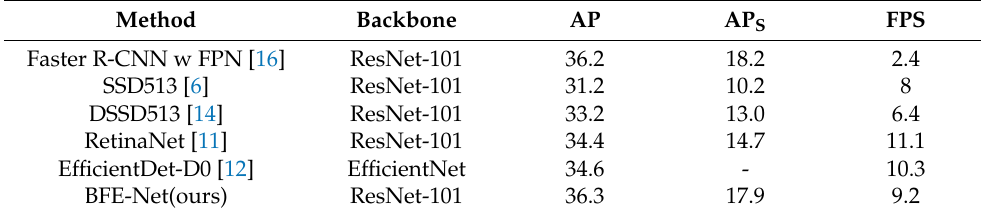
Table 2. Comparison of Speed on COCO test-dev.